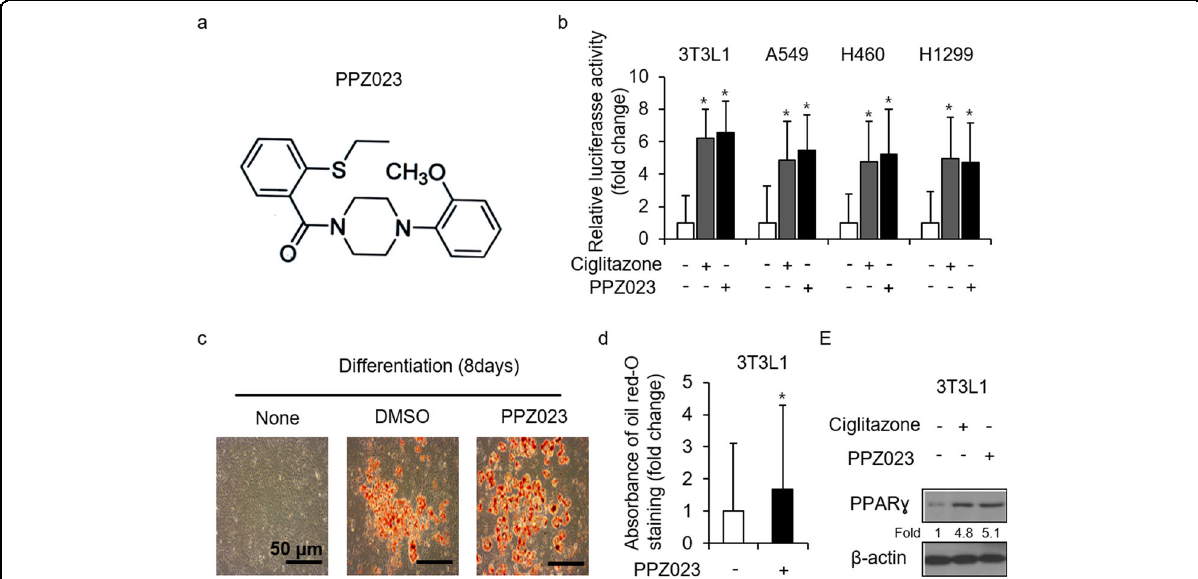
Fig. 1 Adipocyte differentiation in PPZ023-treated 3T3L1 cells. a The chemical structures and molecular formulae of PPZ023. b 3T3L1, A549, H460, and H1299 cells were transiently transfected with 2 μ g of the PPAR response element reporter gene (pGL3-PPRE vector) and the pGL3-PPRE vector and treated with PPZ023 or ciglitazone (Cig) at the indicated doses (PPZ023 25 μΜ ; Cig, 10 μΜ ); * p < 0.05. c PPZ023 (25 μΜ , 24 h)-mediated adipocyte differentiation was assessed by the presence of Oil Red O-stained droplets. Oil Red O-stained cells were detected using a light microscope by scoring cells from each dish at ×400 magni fi cation. d Oil Red O quanti fi cation was performed by adding dye extraction solution to each well and measuring the absorbance at 510 nm. Values are shown as the mean ± SE of three replicates (* p < 0.05, ** p < 0.01 vs. control; Student ’ s t-test). e The effect of PPZ023 (25 μΜ , 24 h) on 3T3L1 cells. Western blotting analyses were conducted to identify the activation of PPAR ɣ . β -Actin was used as the protein loading